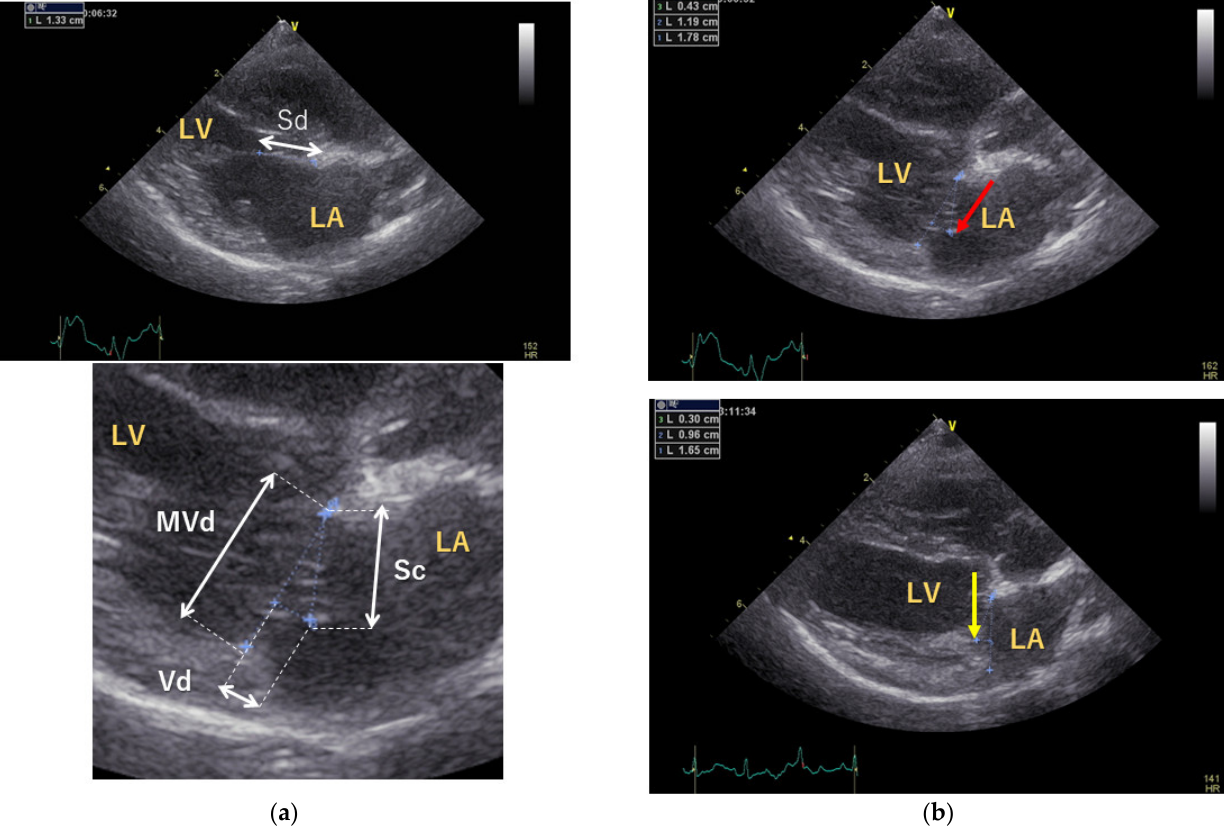
Figure 1. Echocardiographic assessment of mitral valve morphology. ( a ) The septal leaflet lengths were measured at end-diastole (Sd) and coaptation (Sc) using a right parasternal four-chamber view. The coaptation length (CL) was calculated using the following formula: CL = Sd-Sc. The CL-index was calculated by dividing the CL by the mitral valve short-axis dimension (MVd) at the end-systole. The vertical distance between the annular line and the closing point (Vd) at the end-systole. The Vd was measured with the left atrial side set to negative and the left ventricular side set to positive. ( b ) The upper and lower figures show the mitral coaptation of the end-systolic mitral valve before and after surgery. After surgery, the mitral valve height (red arrow) was reduced, and mitral valve coaptation was seen in the left ventricle (yellow arrows). LA: left atrium; LV: left ventricle; Sd: septal leaflet length at end-diastole; Sc: septal leaflet length at coaptation; CL: coaptation length; MVd: mitral valve short-axis dimension at end-systole; Vd: vertical distance between annular line and closing point at end-systole.